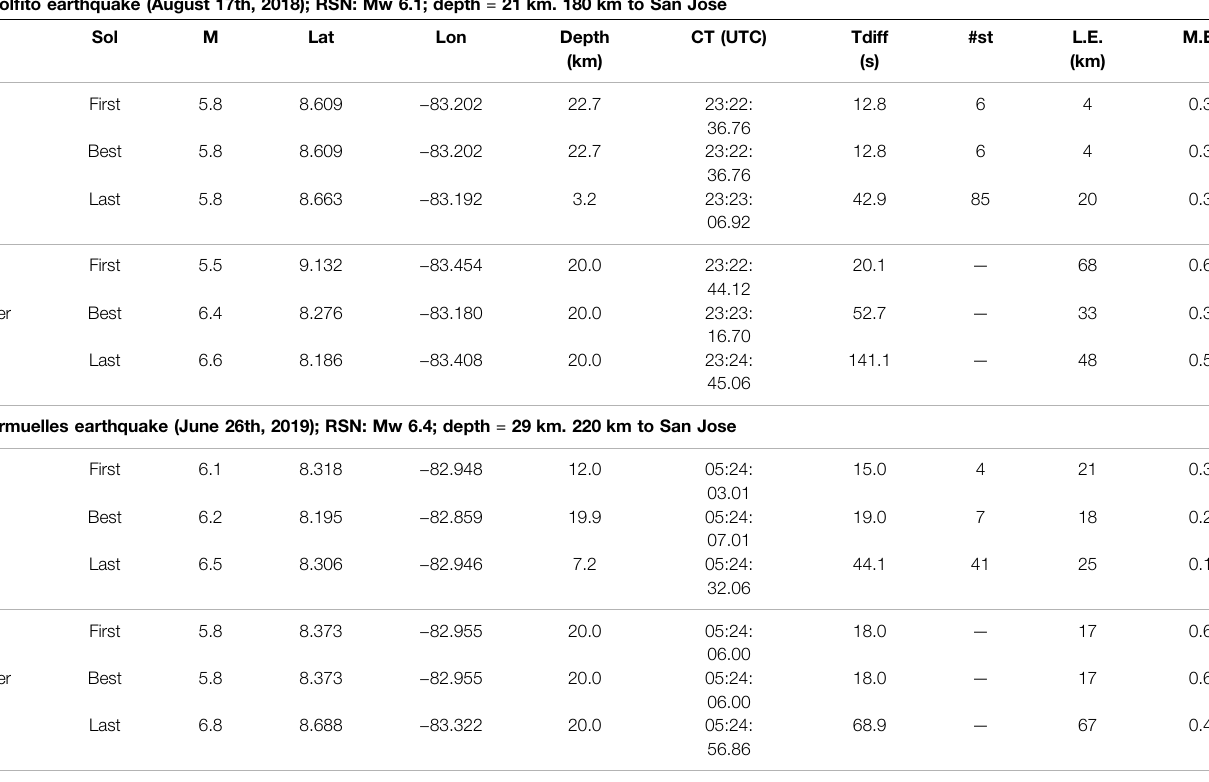
TABLE2| SolutionsoftheVirtualSeismologist(VS)andFiniteFaultRuptureDetector(FinDer)fortheGol fi toandArmuellesearthquakes.Sol (cid:1) solution,M (cid:1) magnitudevalue (VS or FinDer), Lat (cid:1) latitude, Lon (cid:1) longitude, CT (cid:1) creation time, Tdiff (s) (cid:1) time difference in seconds between CT and OT, #st (cid:1) number of stations used in the VS solution, L.E. (km) (cid:1) location error, and M.E. (cid:1) absolute value of magnitude error. The best solutions are chosen when the smallest location differences are obtained compared to the RSN